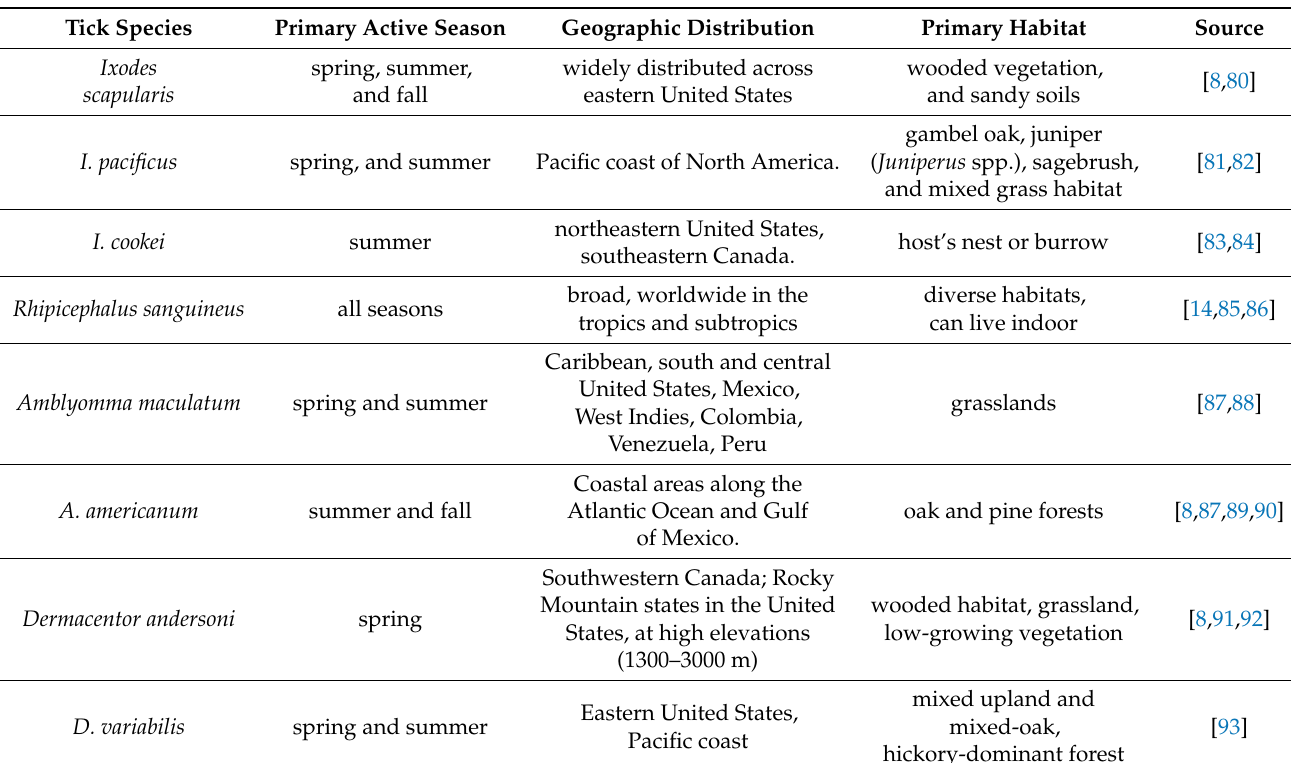
Table 1. Summary of the seasonal activity, geographic distribution, and habitat of the eight tick species. Tick